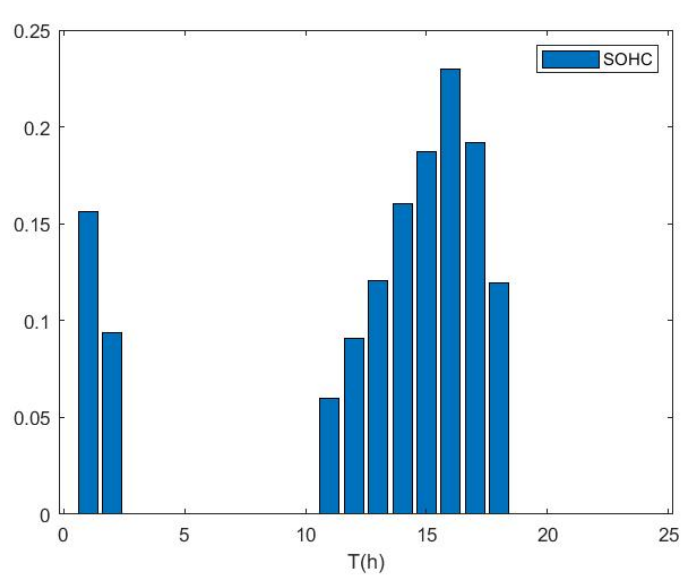
Figure 8. Hydrogen state of the hydrogen tank.